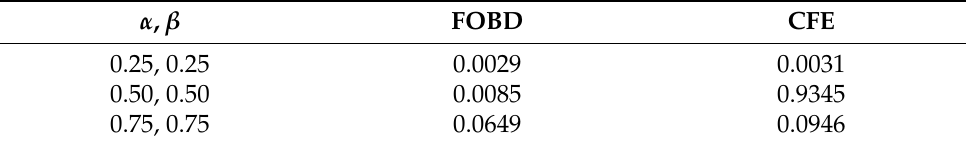
Table 6. Cost function ISE (21) for both approximations and all considered